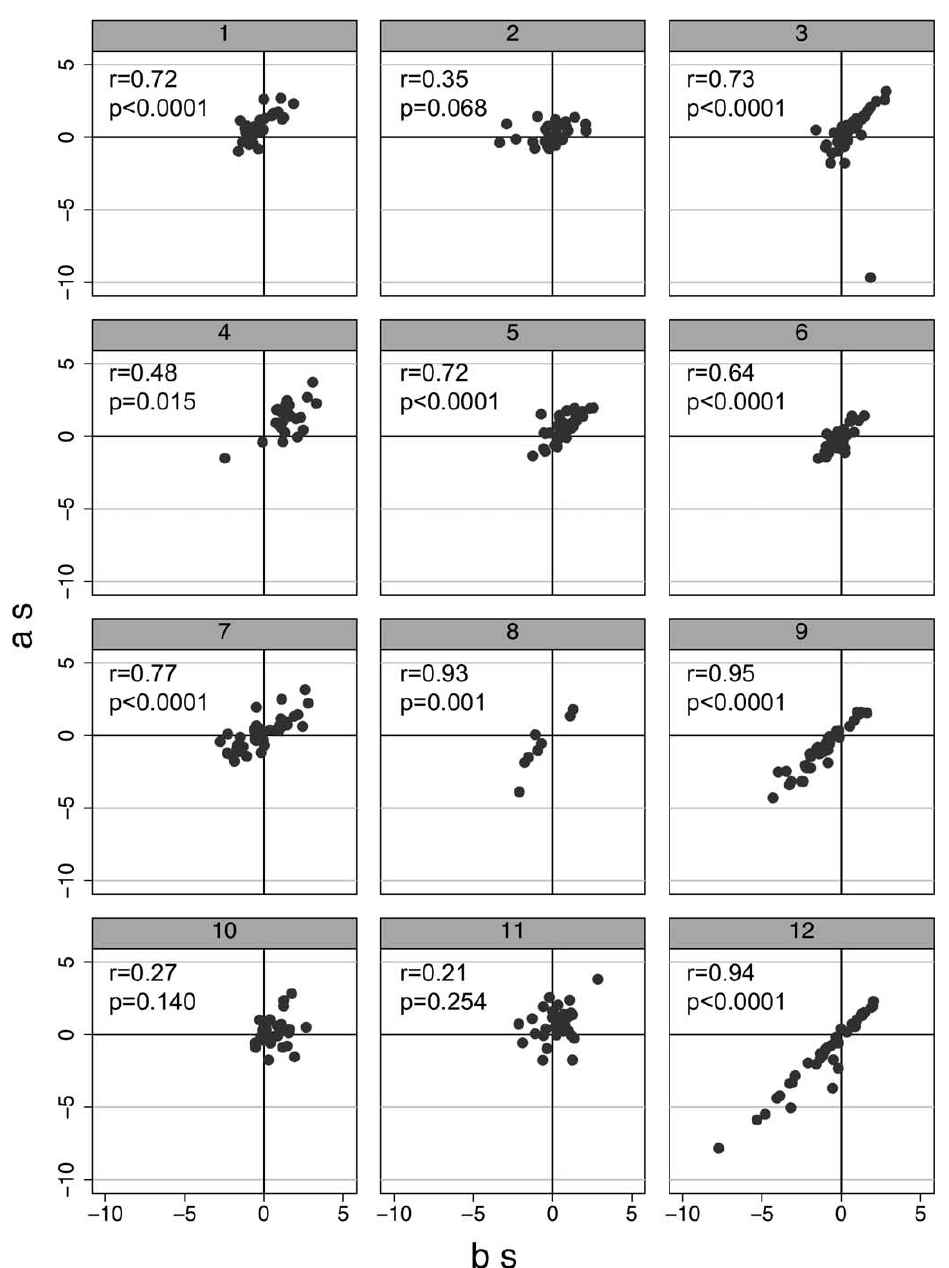
Fig. 2. Scatterplot and Spearman Correlations of the intra-patient FNA pairs. The tumors were split in half and sampled by FNA (termed FNA-A (a s) and FNA-B (b s)). High intra-patient correlations were observed in 9 patients, while tumor halves from patients no. 2, 10 and 11 could not be statistically matched, indicating genetic heterogeneity. Only patient no. 12 was ER − ; the remaining were 100%